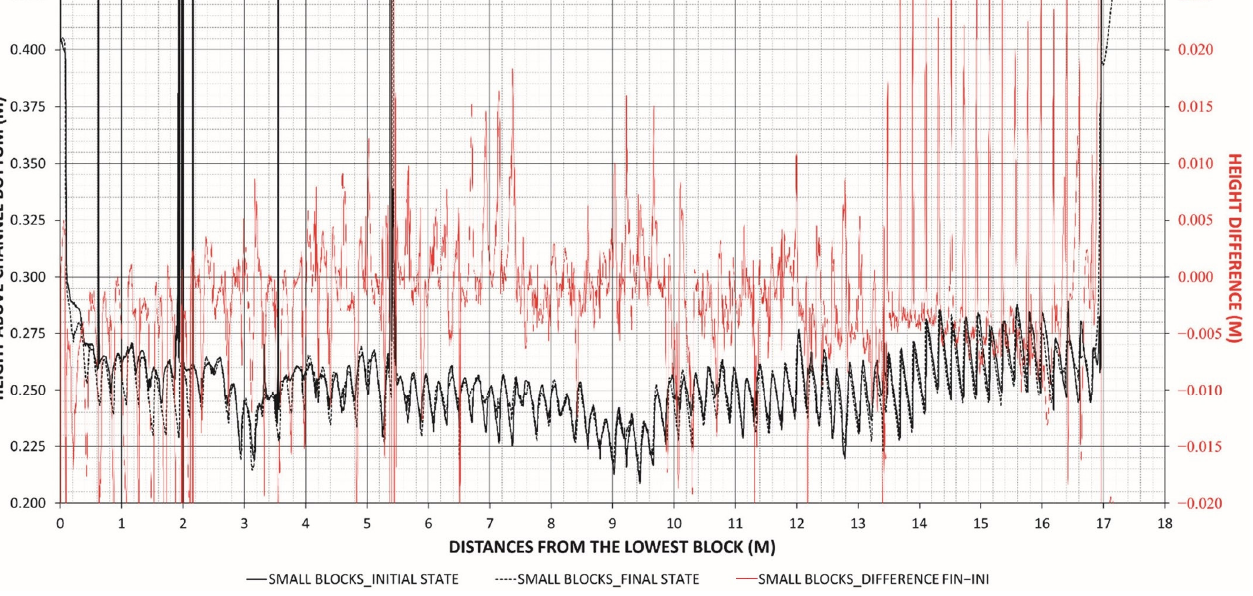
Figure 18. Longitudinal profiles in small blocks: initial state (continuous black line), final state (continuous dotted line), and difference final vs. initial (red line).